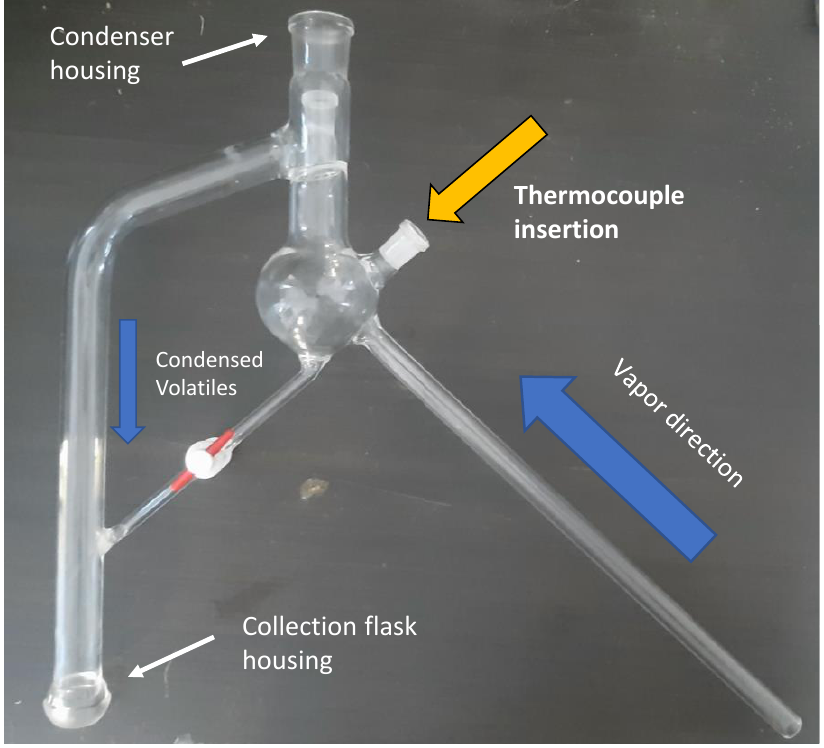
Figure 6. Customized glass apparatus implemented during MAHD under vacuum. The optical fiber is placed right at the vapor output, whilst a slight vacuum (approximately 0.05 MPa) is applied to enhance the distillation, allowing higher extraction yields to be reached with lower energy consumption. The MAHD were tested at two different temperatures, namely, 95 and 99 °C (Table 7), to screen the flexibility of the system. From an engineering point of view, the heating profile and irradiation trend accurately followed the set parameters. The wattage emissions were strongly reduced, which decreased the energy consumption accordingly. For example, in the ramp stage, mild MAHD absorbed 1245 W. Hence, vacuum protocols saved approximately 40% and 20.6%, at 95 and 99 °C, respectively (entries 17 and 18). Table 7. Vacuum MAHD. Biomass: Fresh hops (700 g); L/S: 1 L/kg.